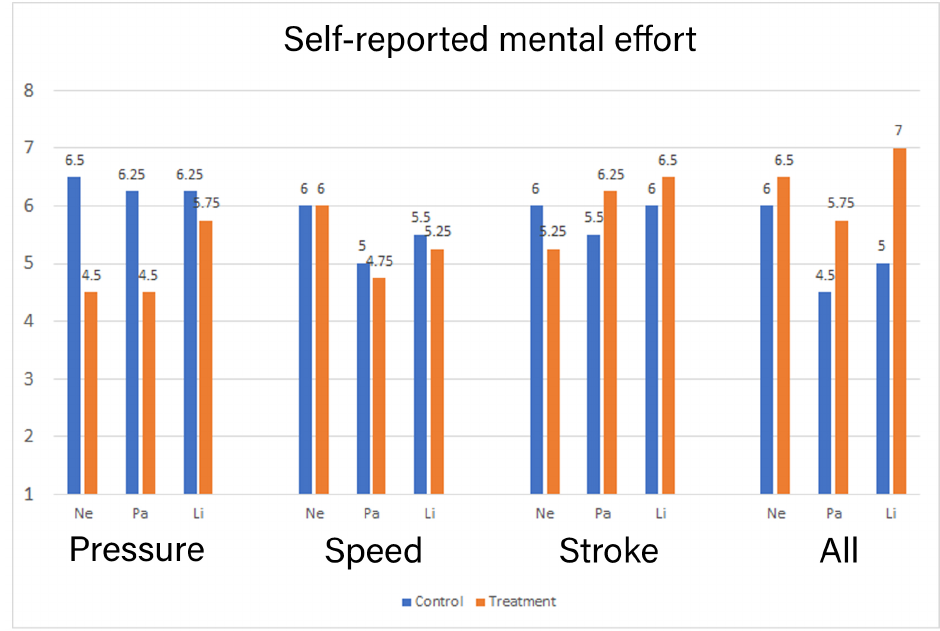
Figure 6. Mean of Self-reported mental effort between two